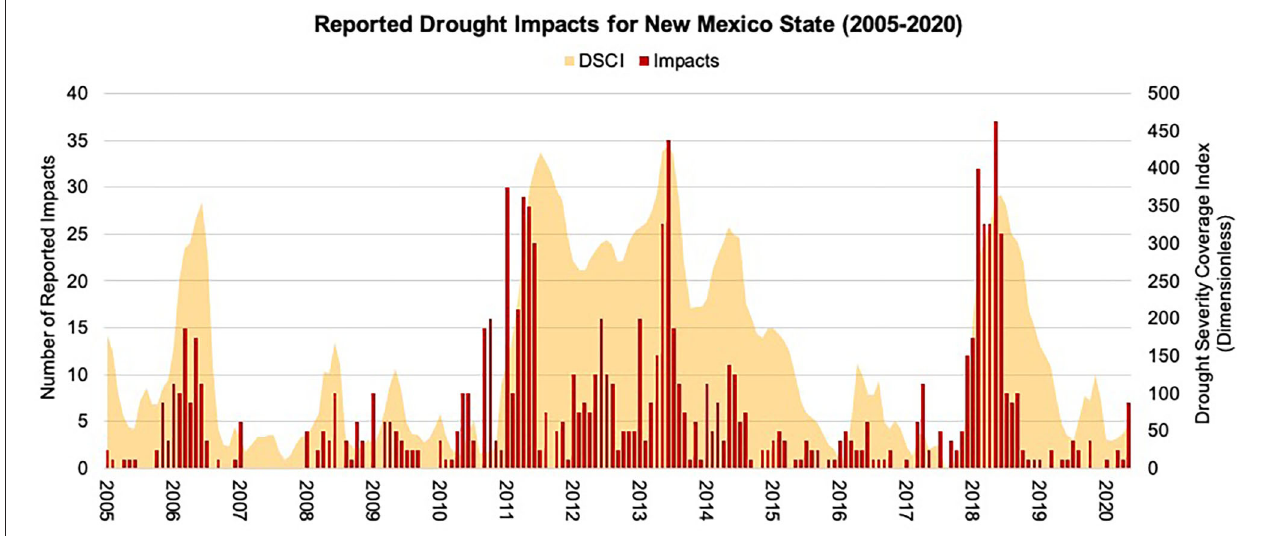
TABLE 5 | Drought Events (DE U s) as designated by the USDM thresholds defined in the 2018 New Mexico Drought Plan. Drought Beginning week Ending week Duration event